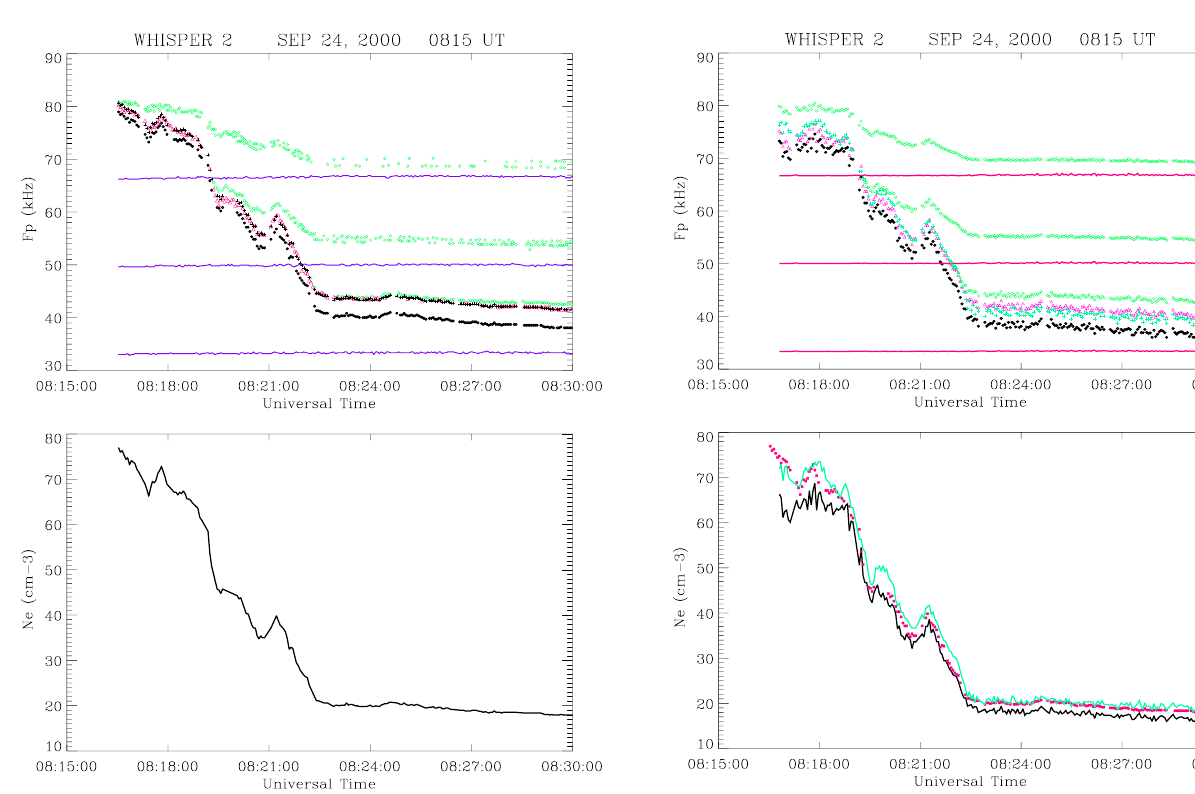
Fig. 8. Frequency of the resonances observed by Whisper-2 during an outbound crossing of the Earth’s plasmapause as a function of time (top). Electron plasma density is deduced from the observed plasma frequency and upper-hybrid frequency resonances (bottom). See details in the text.